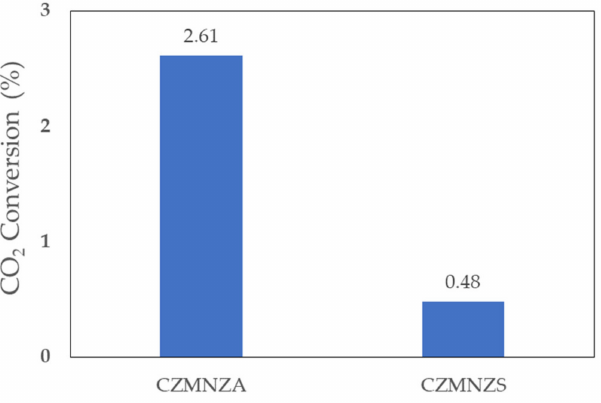
Figure 13. CO 2 conversion over Al 2 O 3 and SBA-15-supported catalysts at reduction temperature 250 ◦ C.